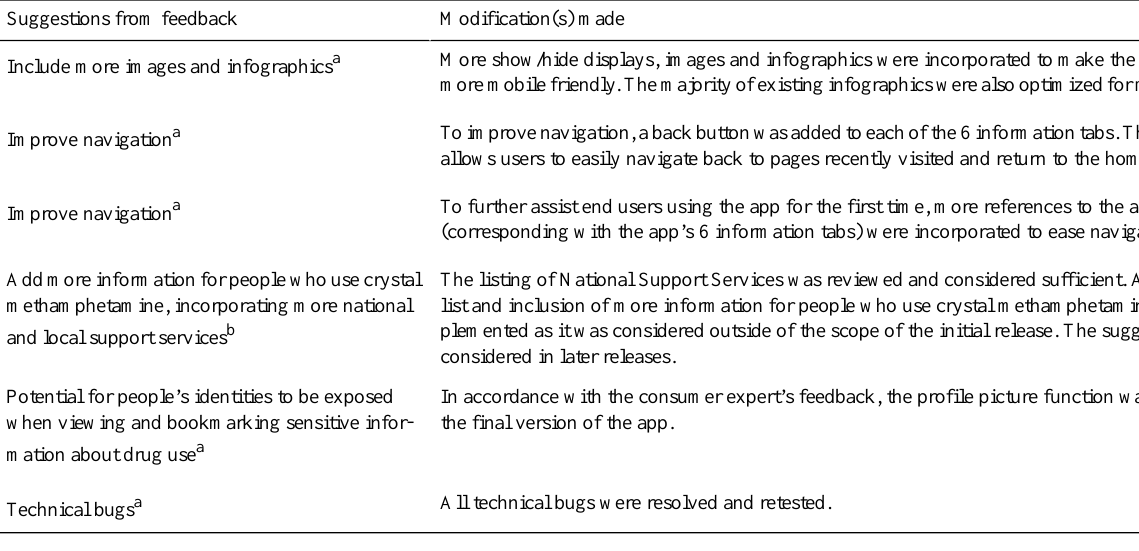
Table 5. Summary of feedback and modifications made to the app.